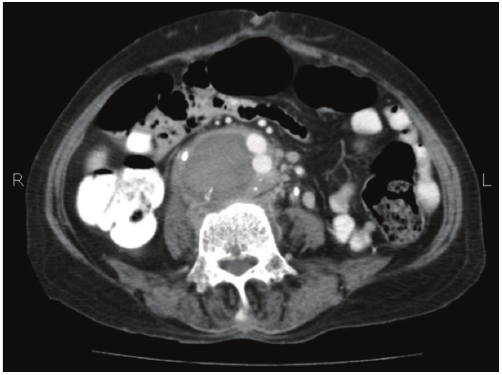
Figure 3: Enhanced CT obtained 15 days after embolization shows that the pseudoaneurysm is